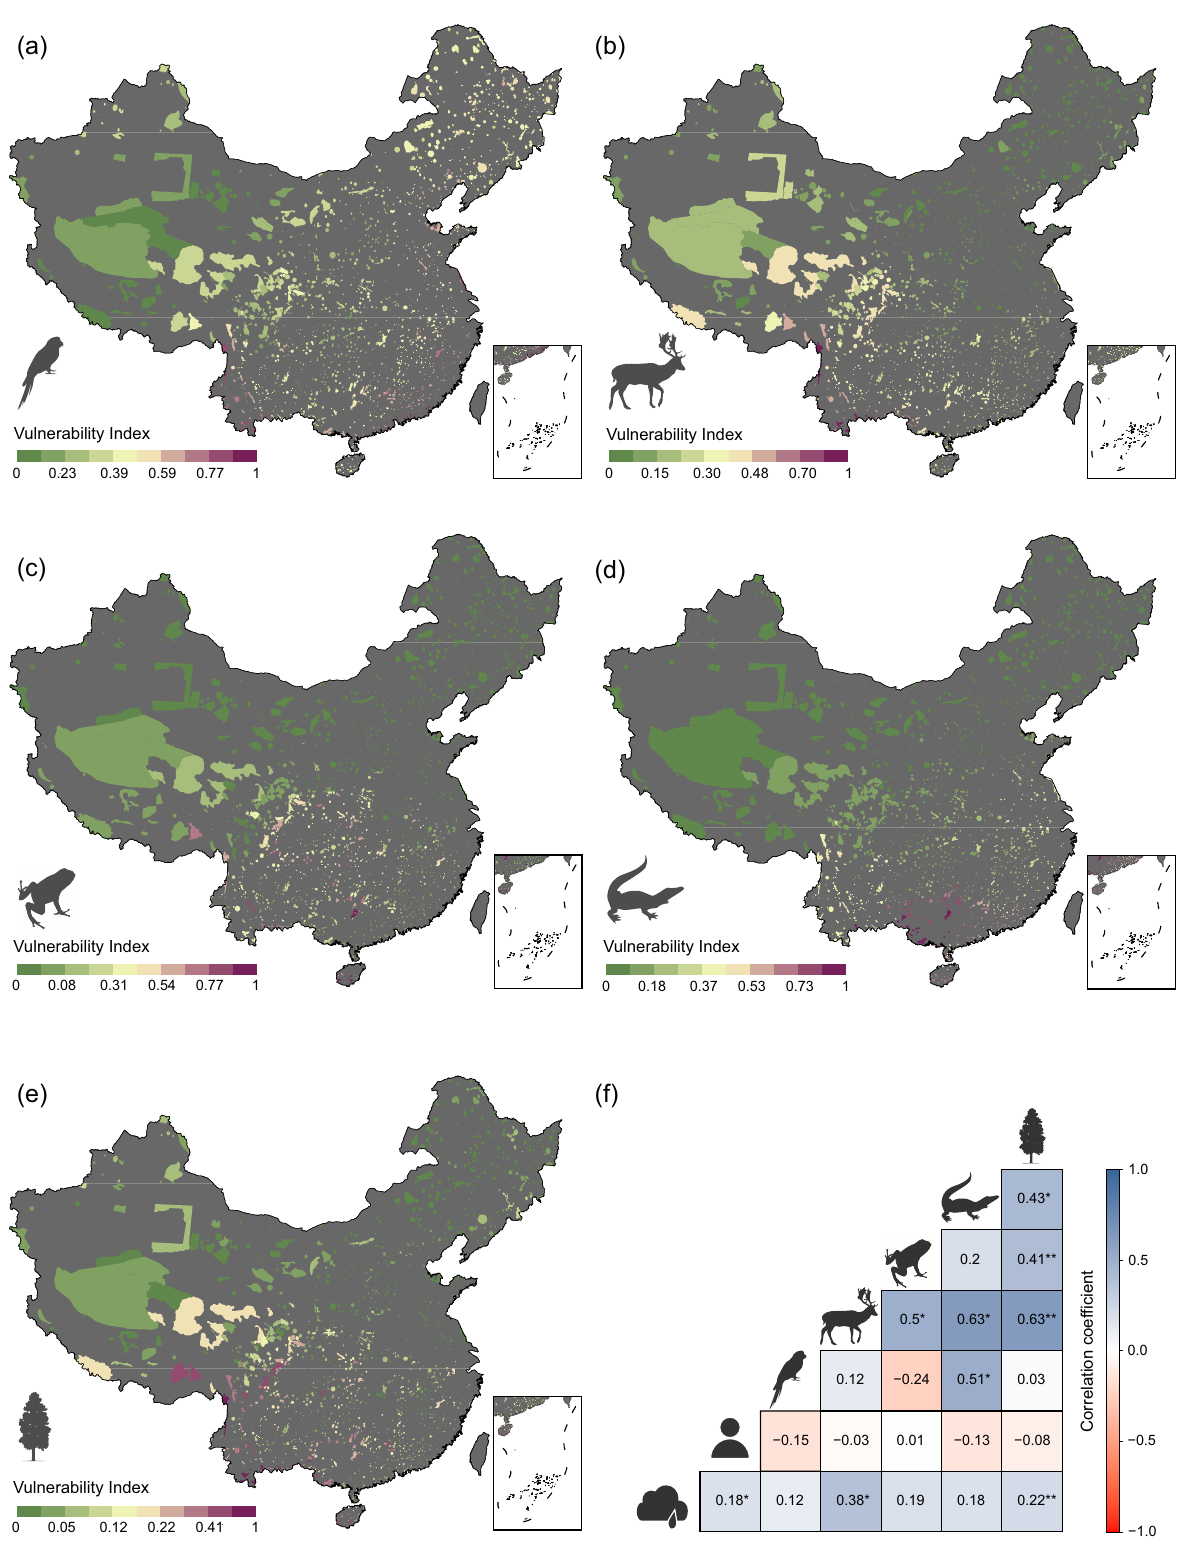
Fig. 2 Spatial patterns of species vulnerabilities across protected areas in China. a birds, b mammals, c amphibians, d reptiles and e plants. Vulnerability index close to 1 represented by warmer color indicates high species vulnerability (i.e., high diversity of threatened species in general, or a high number of highly threatened species, such as critically endangered, or both). f Pearson ’ s correlation coef fi cients between climate, anthropogenic and species vulnerabilities. The signi fi cance of the correlation tests was computed using modi fi ed t -test. ** p < 0.01, * p < 0.05. Values without an asterisk (*) are not signi fi